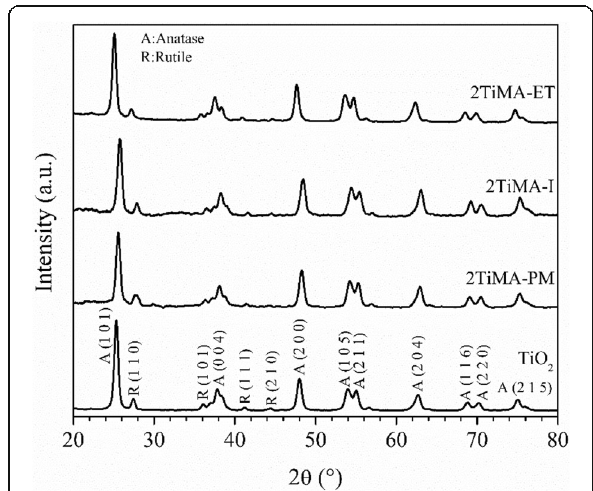
Fig. 3 XRD patterns of the samples: pristine TiO 2 , 2TiMA-M, 2TiMA-I, and 2TiMA-ET